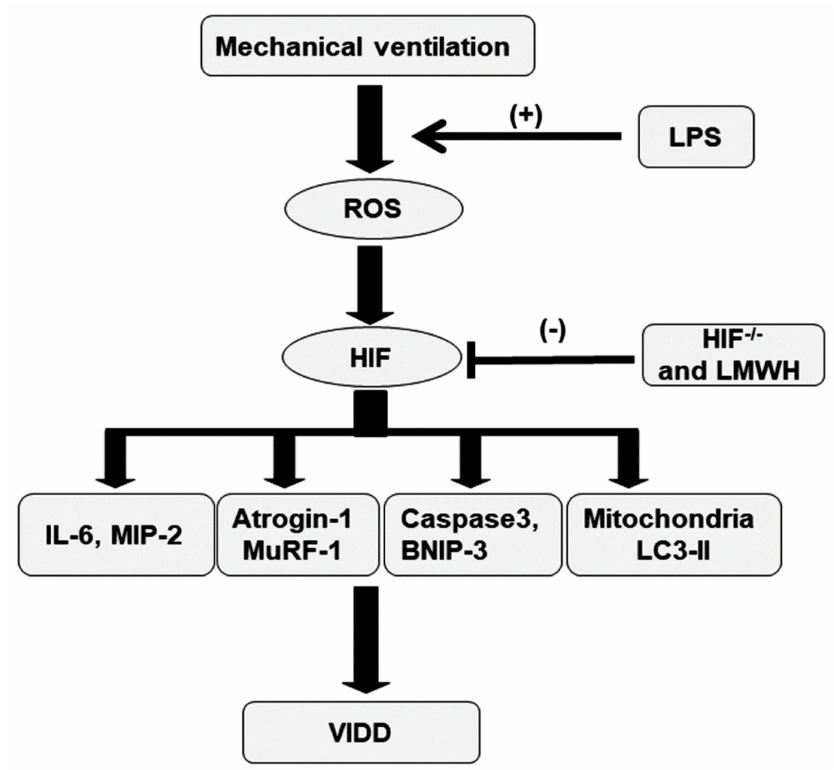
Figure 8. Schematic figure illustrating the signaling pathway activation with. mechanical ventila- tion and endotoxemia. Endotoxin-induced augmentation of mechanical stretch-mediated cytokine production and diaphragm damage were attenuated by the administration of enoxaparin and with HIF-1 α homozygous knockout. HIF = hypoxia-inducible factor; IL = interleukin; LC3-II = light chain 3-II; LMWH = low-molecular-weight heparin; LPS = lipopolysaccharide; MIP-2 = macrophage inflammatory protein-2; MuRF-1 = muscle ring finger-1; ROS = reactive oxygen species; BNIP- 3 = BCL2/adenovirus E1B 19 kDa protein-interacting protein 3; VIDD = ventilator-induced di- aphragm